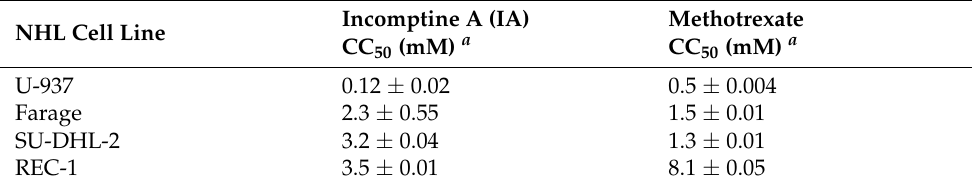
Table 1. Cytotoxic activity of incomptine A in CC 50 (mM) ± SEM against four sub-types of NHL human cell